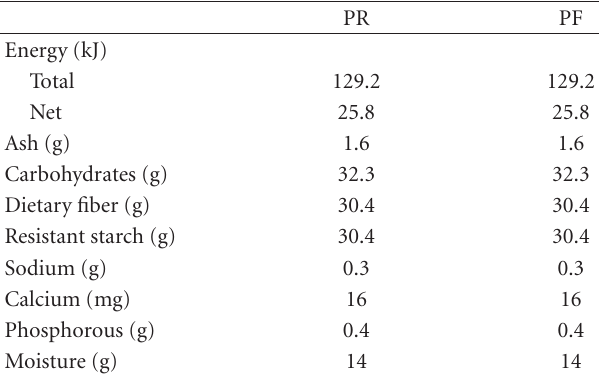
Table 1: The nutrient composition as provided per 38g of each